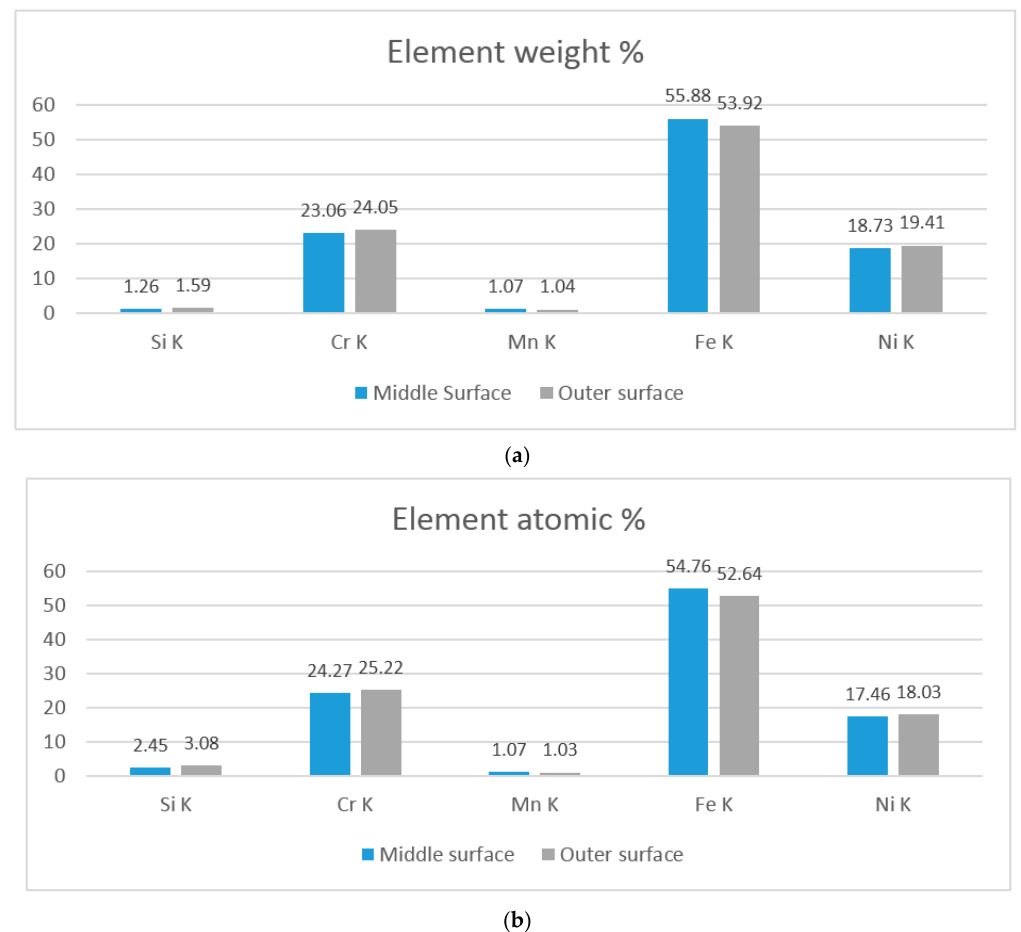
Figure 10. ( a ) Element weight percentage results given by an X-ray microanalysis performed on the middle and outer surface of an as-cast sample; ( b ) Element atomic percentage results given by an X-ray microanalysis performed on the middle and outer surface of an as-cast sample.